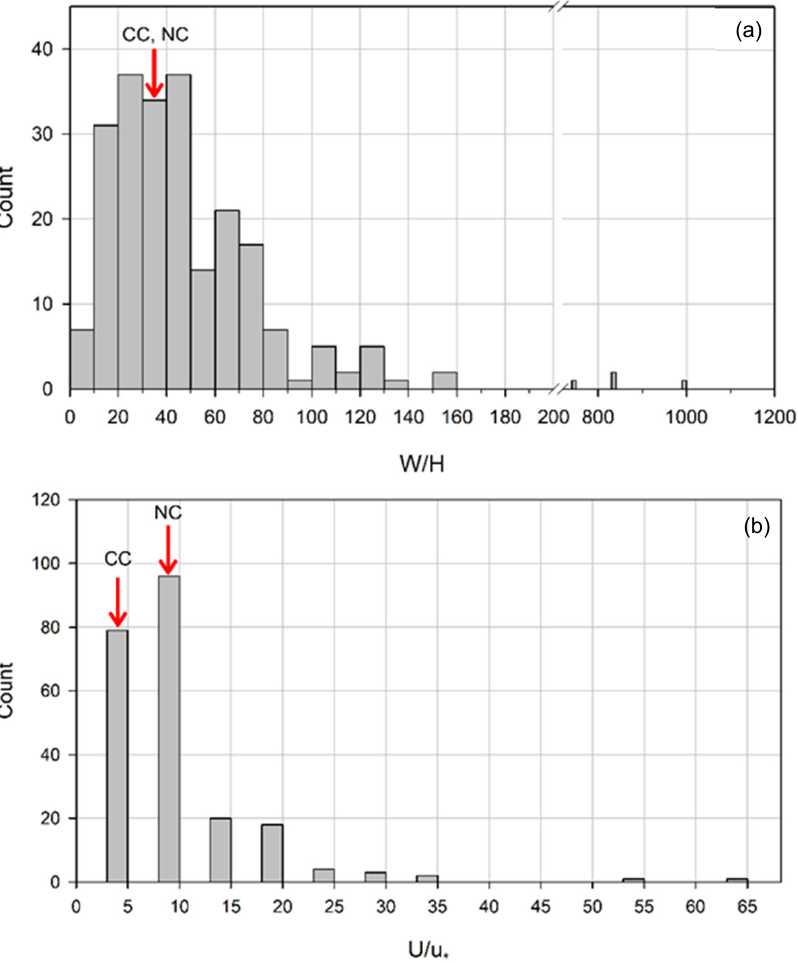
Figure 13. Frequency distribution of the data utilized to calibrate the empirical formulas for the longitudinal dispersion coefficient in Table 1. ( a ) W/H frequency distribution; ( b ) U/u ∗ frequency distribution. The red arrows indicate the ranges corresponding to channels in this study.